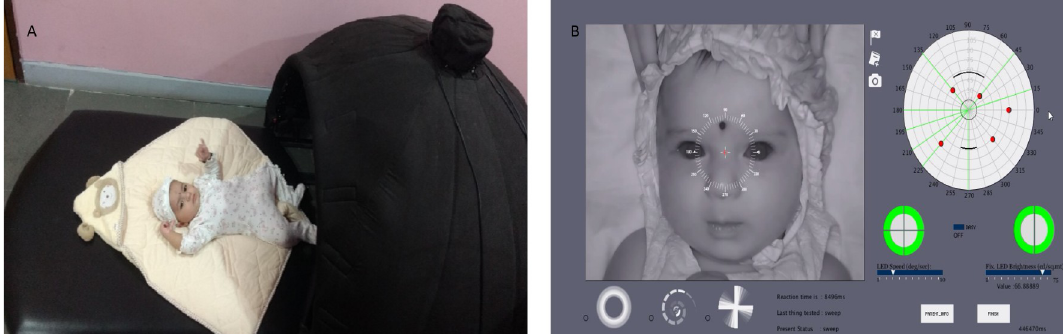
Fig 1. (A) Photograph of an infant before sliding into the Pediatric Perimeter device. (B) Graphical User Interface (GUI) and infrared image capture of the infant’s face is seen. The green colored hemi-circle and quadrants in the lower right represent the stimuli for the Gross Visual Field